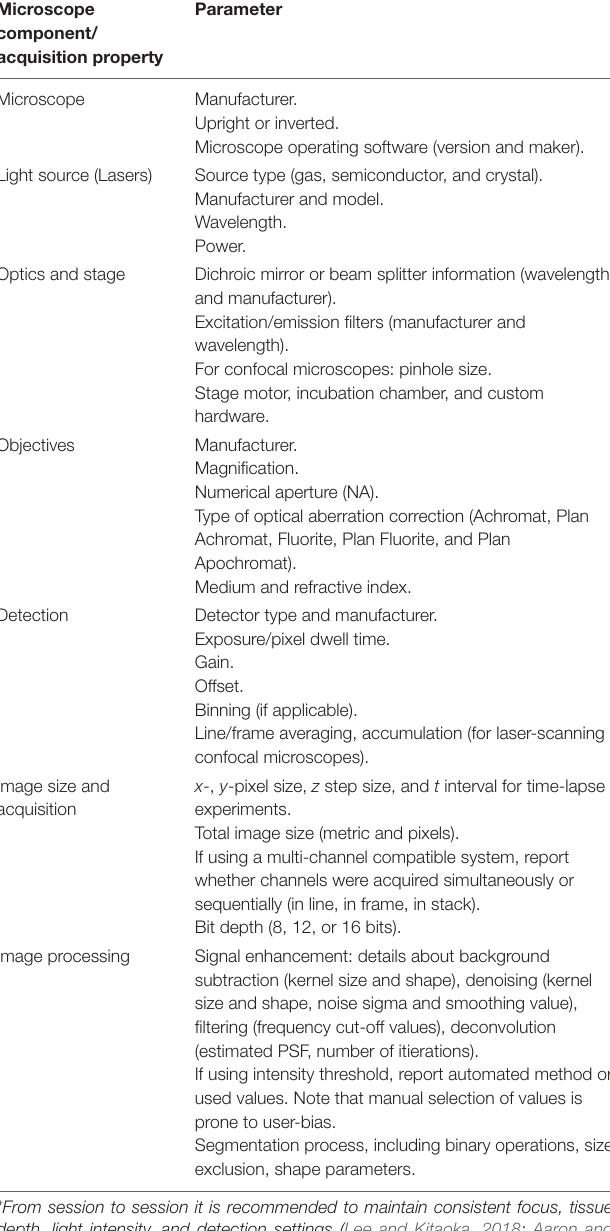
TABLE 2 | Methodological image acquisition parameters to report in scientific